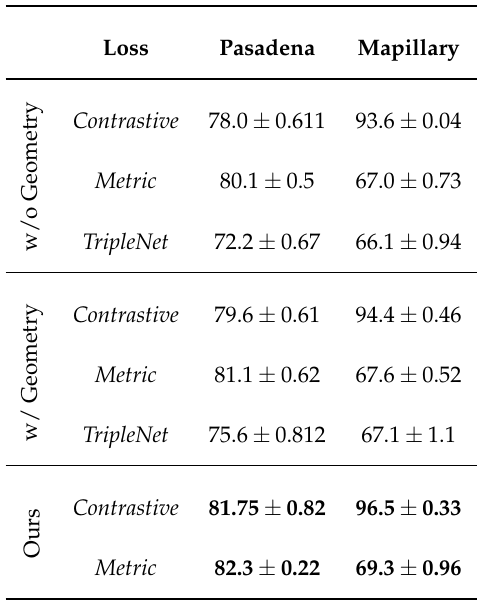
Table 1. Matching accuracy (in %) and standard deviation matching results for w/o Geometry , w/ Geometry , and Ours on the two datasets and losses. The best results are marked